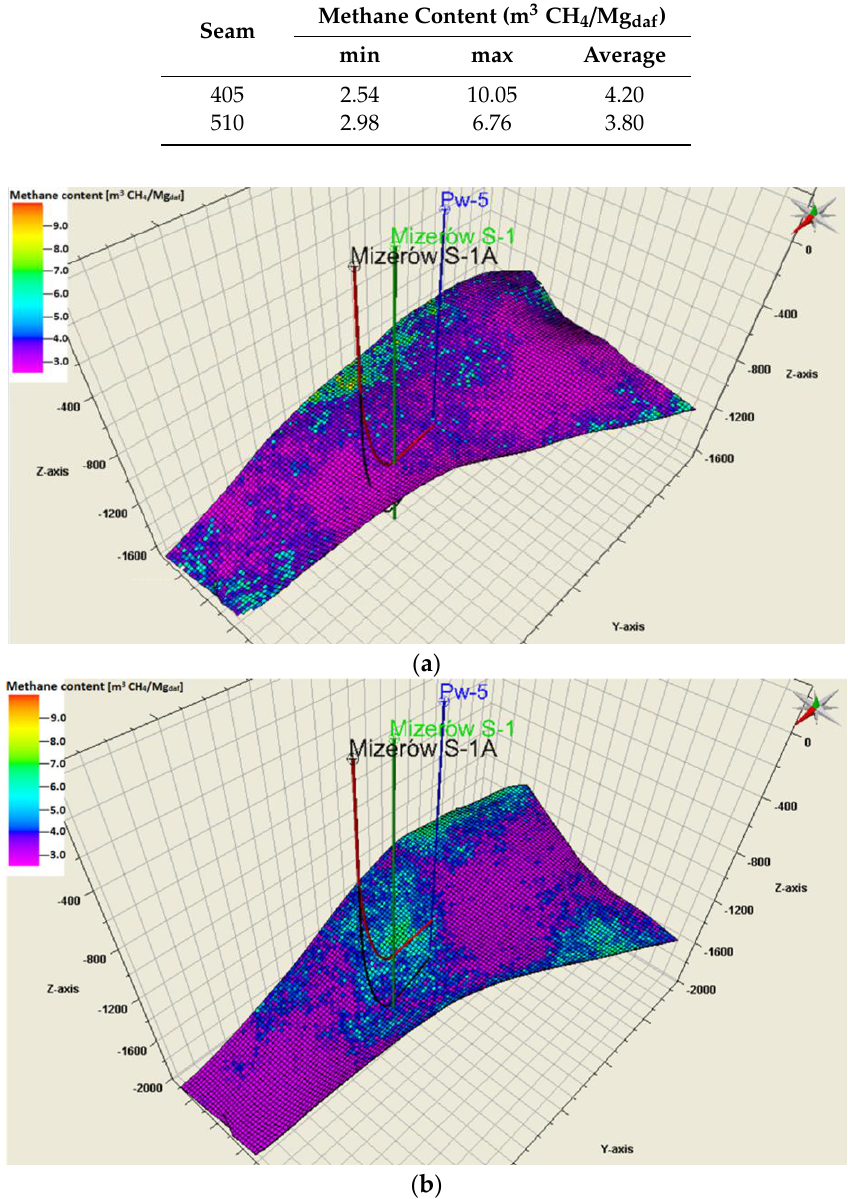
Figure 5. The distribution of methane content for seams: ( a ) 405 and ( b ) 510.